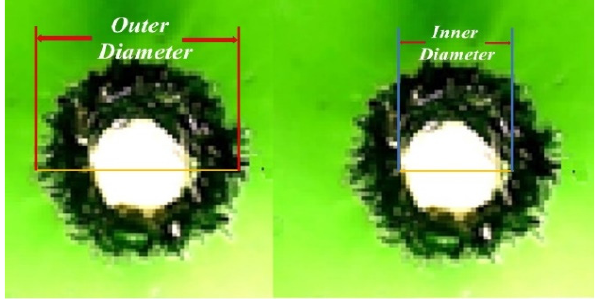
Figure 3. Hillock measurement of the inner and outer diameters.